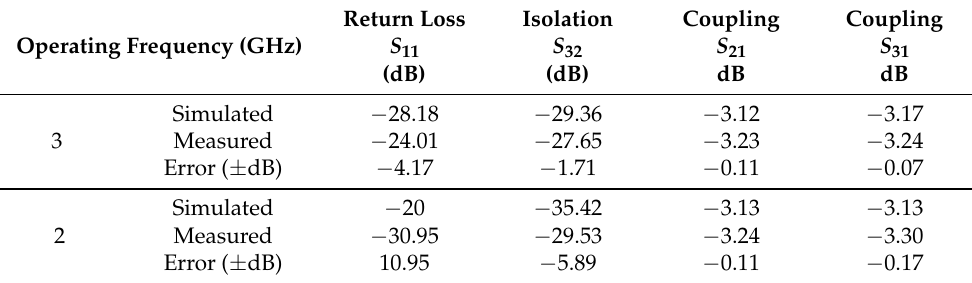
Table 4. Comparisons of S-parameters at the resonating frequencies of 2 and 3 GHz of the simulated and fabricated